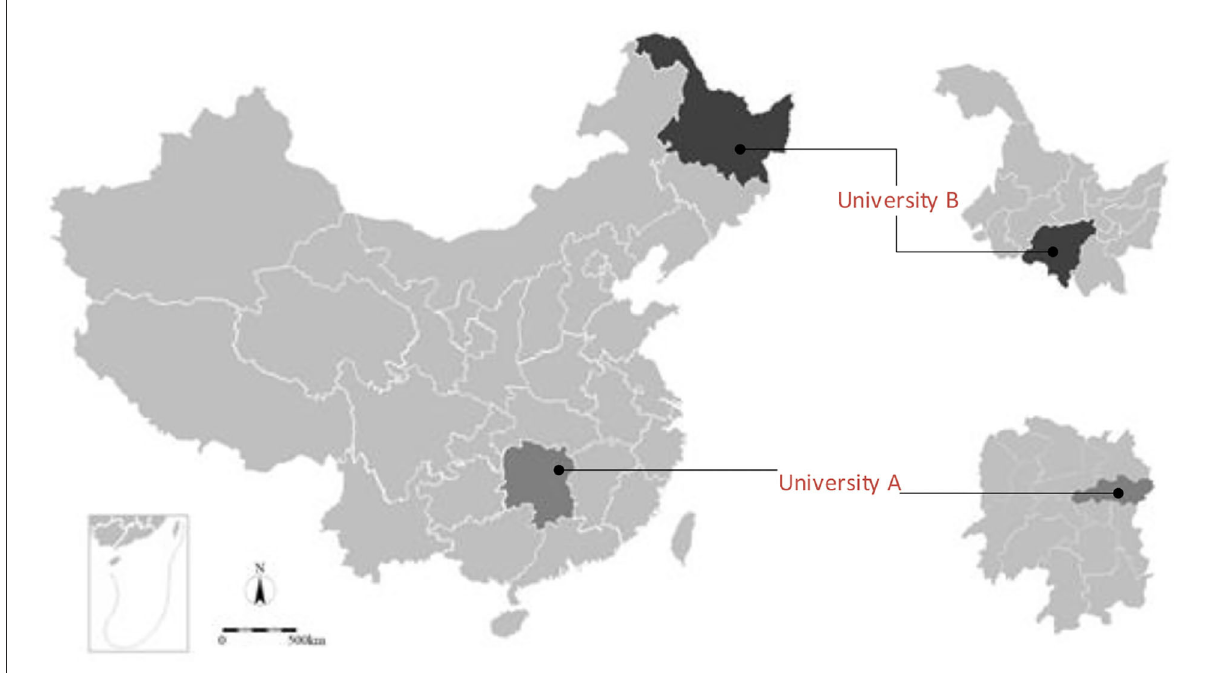
FIGURE2 Locations of university campuses in different provinces in China.